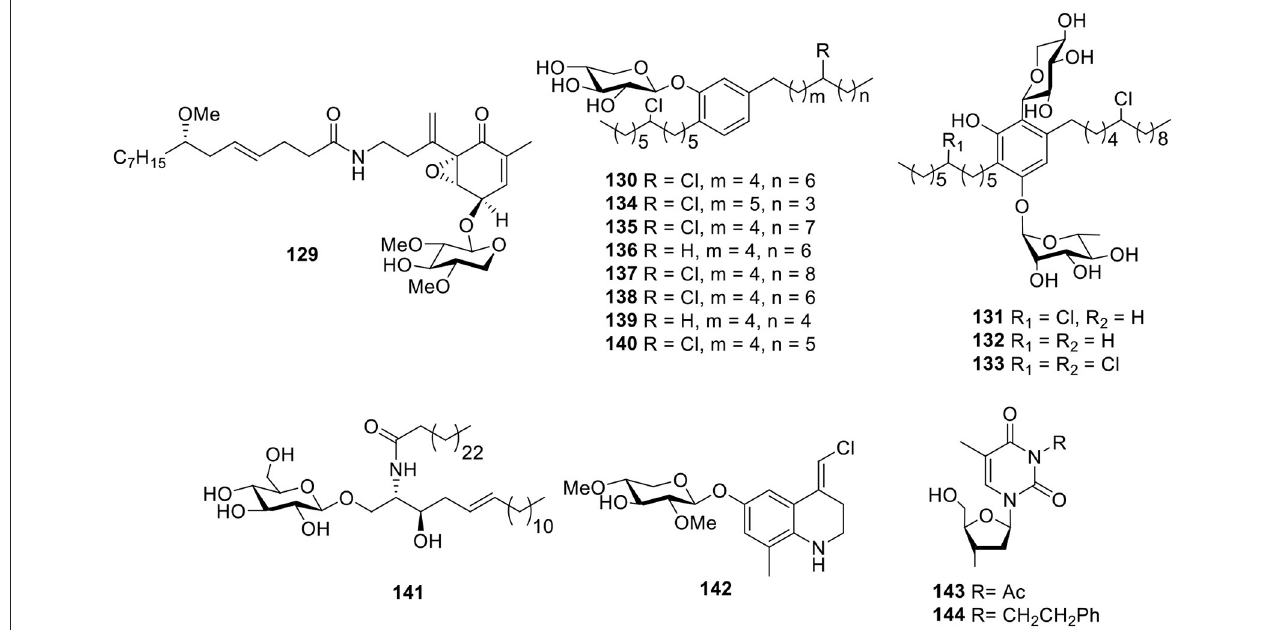
FIGURE 10 | Chemical structures of compounds 129–144 derived from marine-sourced